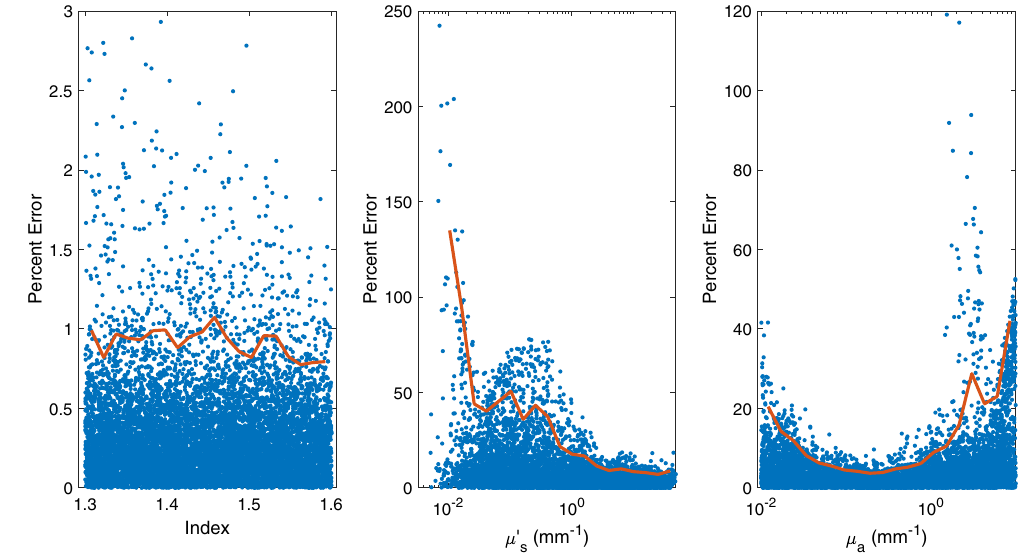
Figure 4. Prediction error for a [21, 150, 150, 150, 3] fully connected neural network illustrating the accuracy of the method across the problem space. The red line is the 95% error level. The errors are large when scattering and absorption are small because the light transport does not depend strongly on these variables in those cases and when the absorption is large because a lot of the light is absorbed in the medium and never reaches a detector. In these three situations a large error is expected and represents a limitation of the physics of the problem more so than a limitation of this technique.